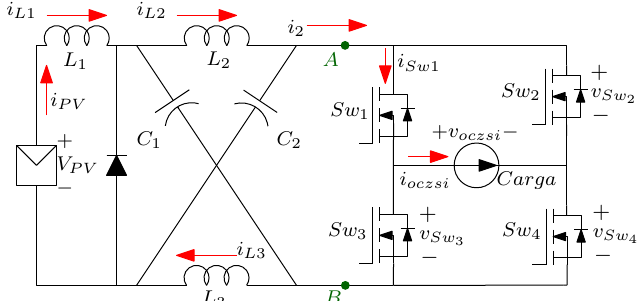
Figure 2. Current-fed Z-source inverter.